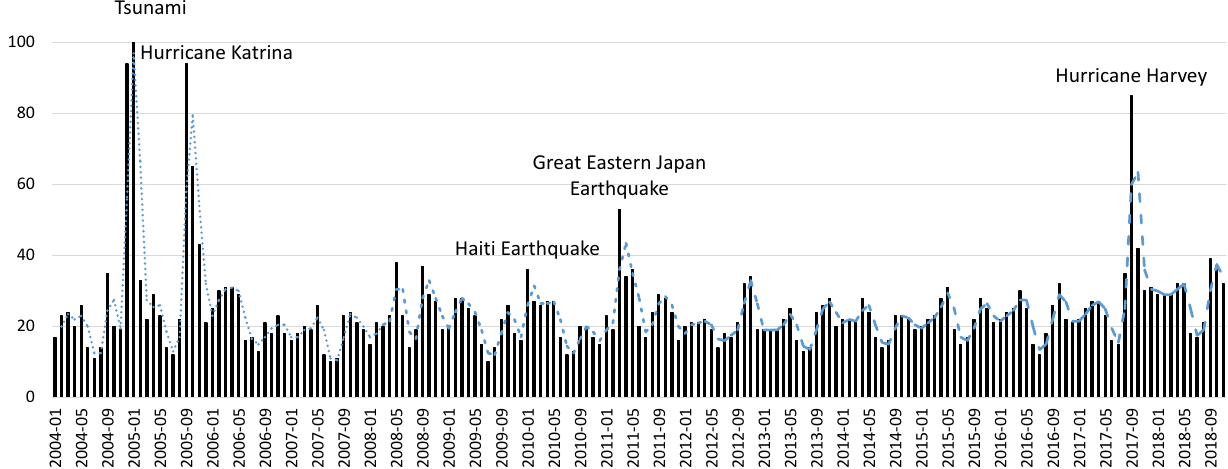
Fig. 1 Percentage increases in Google searches using the term ‘‘natural disaster’’ in the United States from 2004 to 2018. Analysis conducted using Google